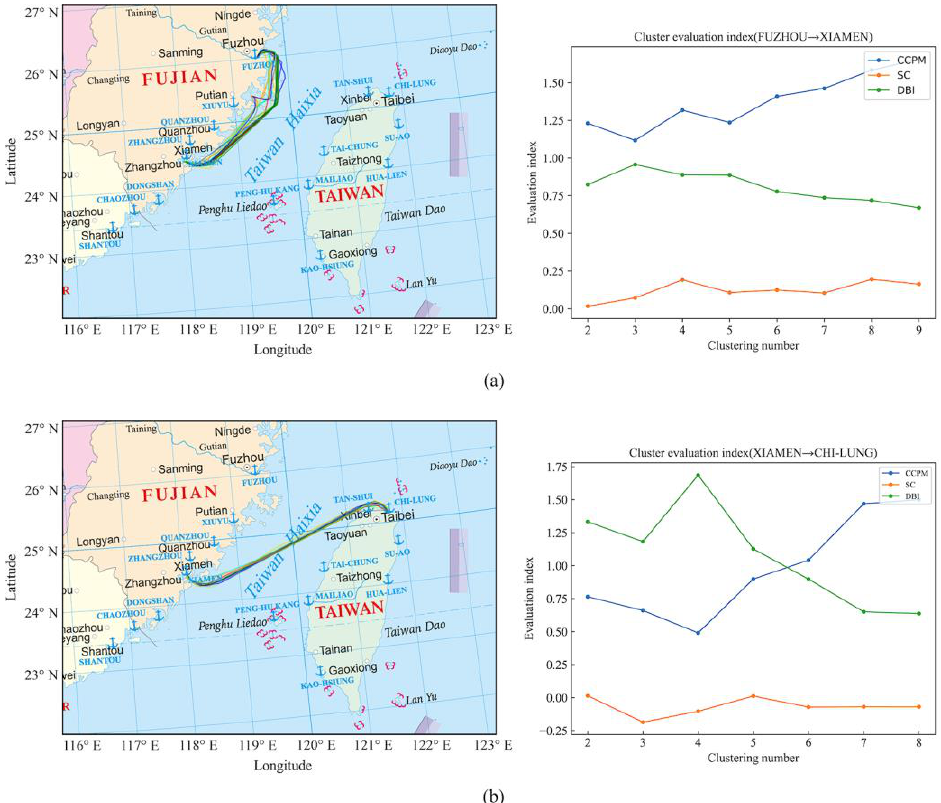
Figure 19. ( a ) BIRCH clustering results and quantitative evaluation results of the ship trajectories from Fuzhou Port to Xiamen Port. ( b ) BIRCH clustering results and quantitative evaluation results of the ship trajectories from Xiamen Port to Keelung Port.